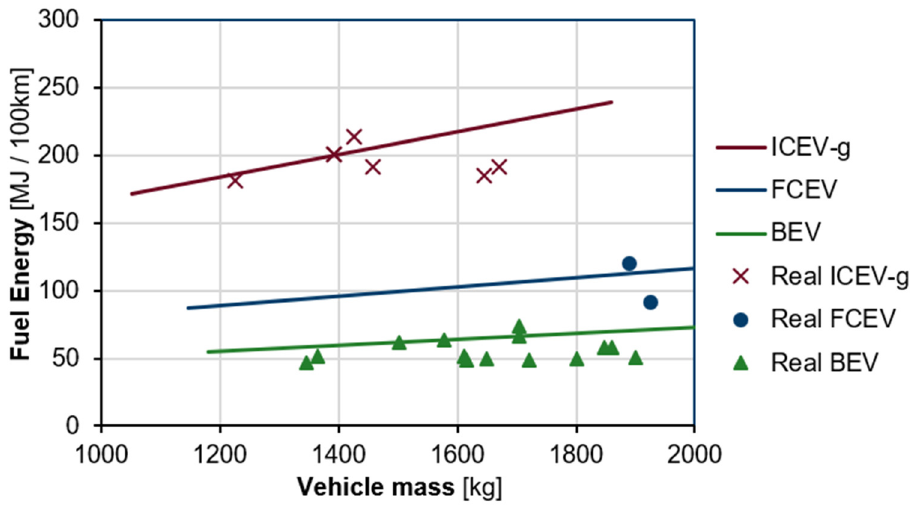
Figure 4. Comparison of manufacturers’ data (WLTC) and model energy demand for medium cars for different vehicle masses ([57,58]). The solid lines represent the model’s results.